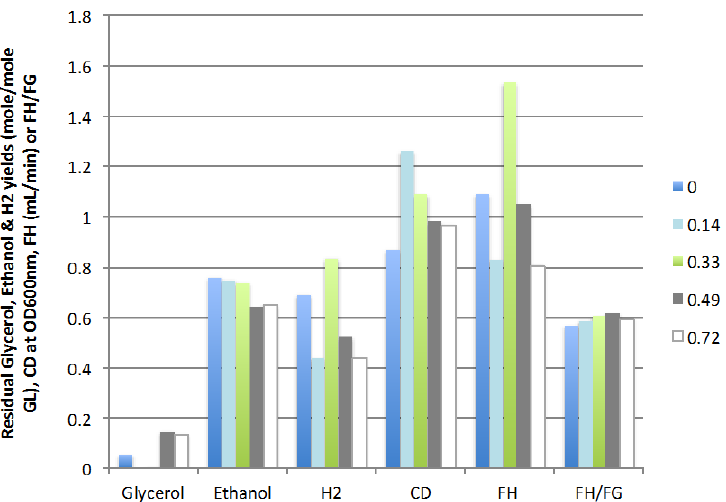
Figure 4. Effect of liquid recycling ratio on residual glycerol, ethanol and hydrogen yields, cell density, rate of hydrogen production (FH), and ratio of H 2 /gas (FH/FG) (3